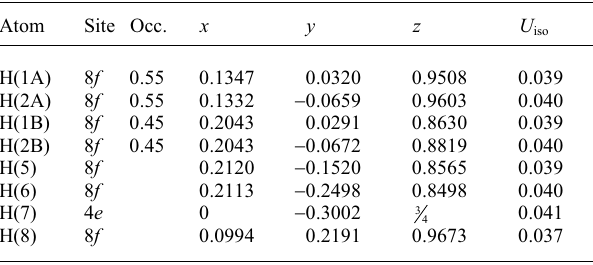
Table 2. Atomic coordinates and displacement parameters (in Å 2 )